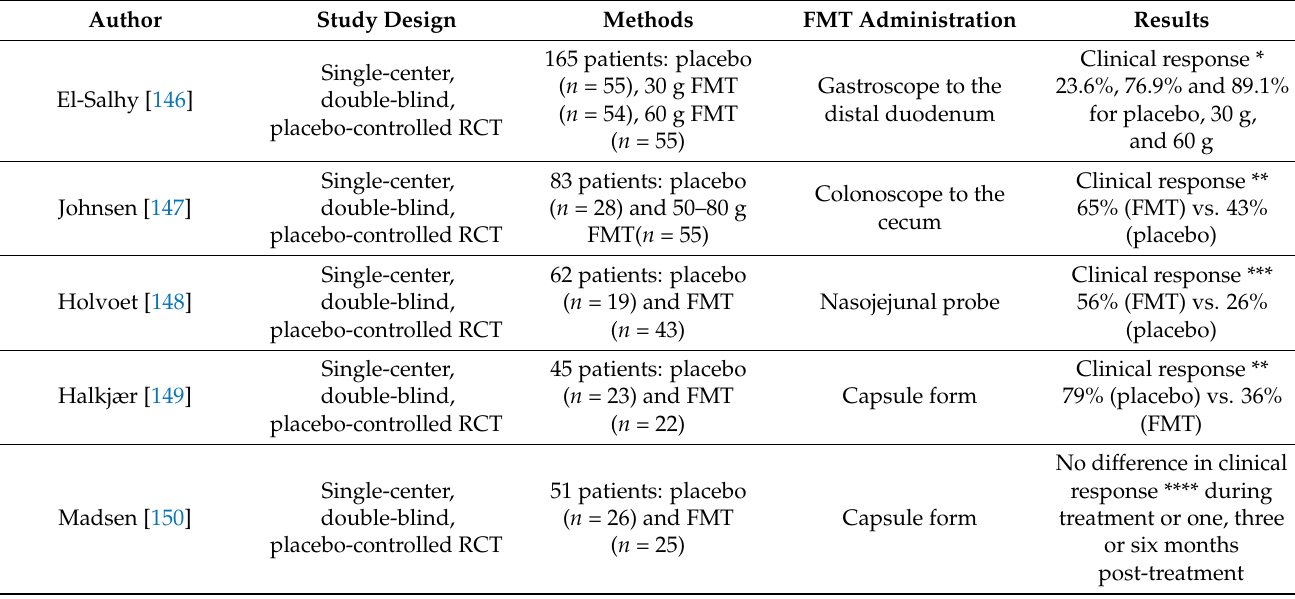
Table 1. Selected fecal microbiota transplantation